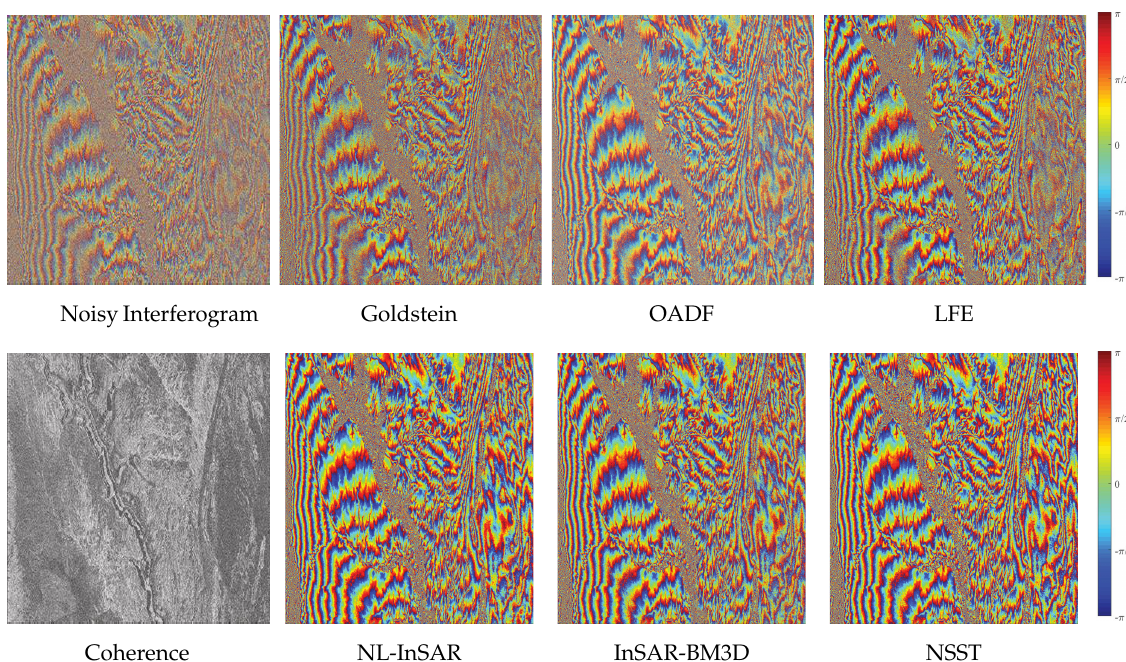
Figure 14. The filtered results of the real interferogram with the longest baseline.